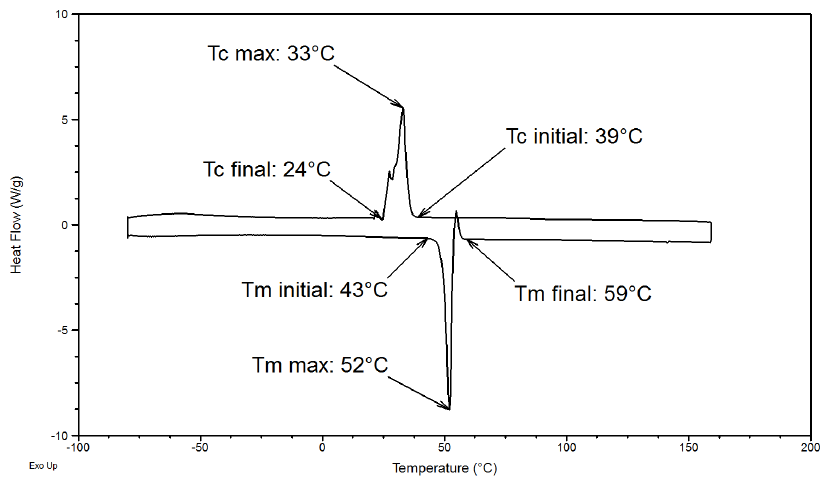
Figure 2. Differential Scanning Calorimetry DSC curves of PEG homopolymer during the heating (down) and the cooling (up) ramps.